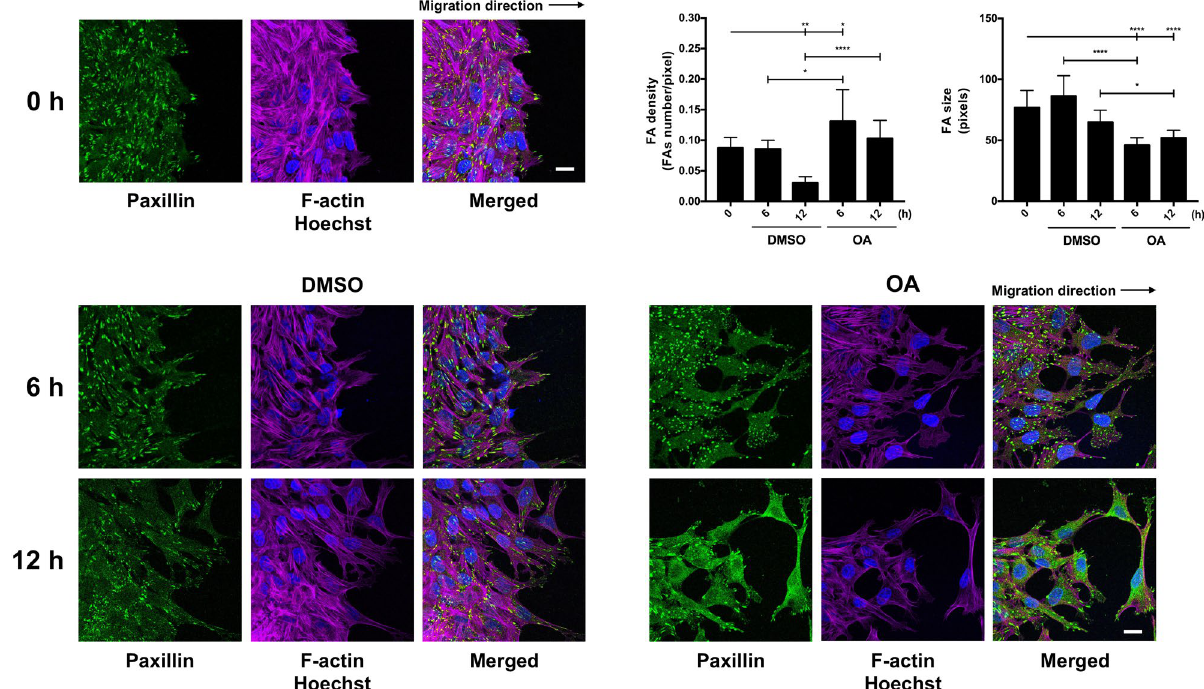
Figure 6. OA promotes changes in FAs and actin cytoskeleton. Confluent Mv1Lu cells were scratched and allowed to migrate for 6 and 12 h. Cells treated with 5 µM OA or DMSO equivalent volume (vehicle control) were immunostained with specific antibodies against paxillin (green). Co-staining with phalloidin and Hoechst-33258 was used to show actin cytoskeleton (magenta) and nuclei (blue), respectively. This experiment was repeated at least three times. Representative images are shown. Scale bar indicates 10 µm. Quantification of the density of FA as FA number per filopodia area. Quantification of FA size (average size) at the filopodia area. One-way ANOVA statistical analysis was performed (*p < 0.05, **p < 0.005, ***p < 0.001 and ****p <